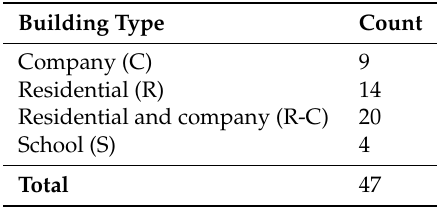
Table 2. Number of buildings of each building